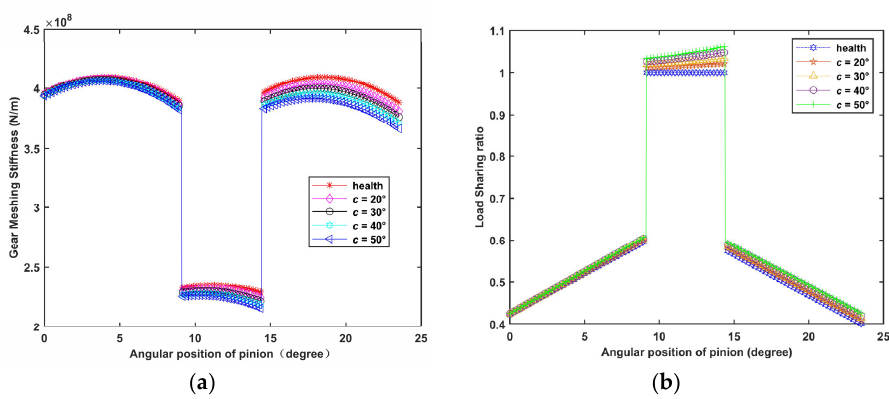
Figure 8. TVMS and LSR with different crack angles: ( a ) TVMS; ( b ) LSR.